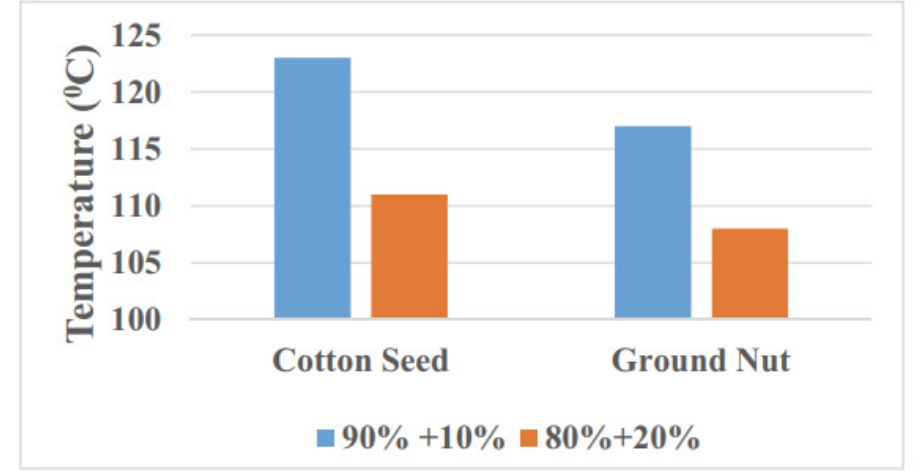
Figure 3. Temperature Variation at Different Cutting Environments [83].